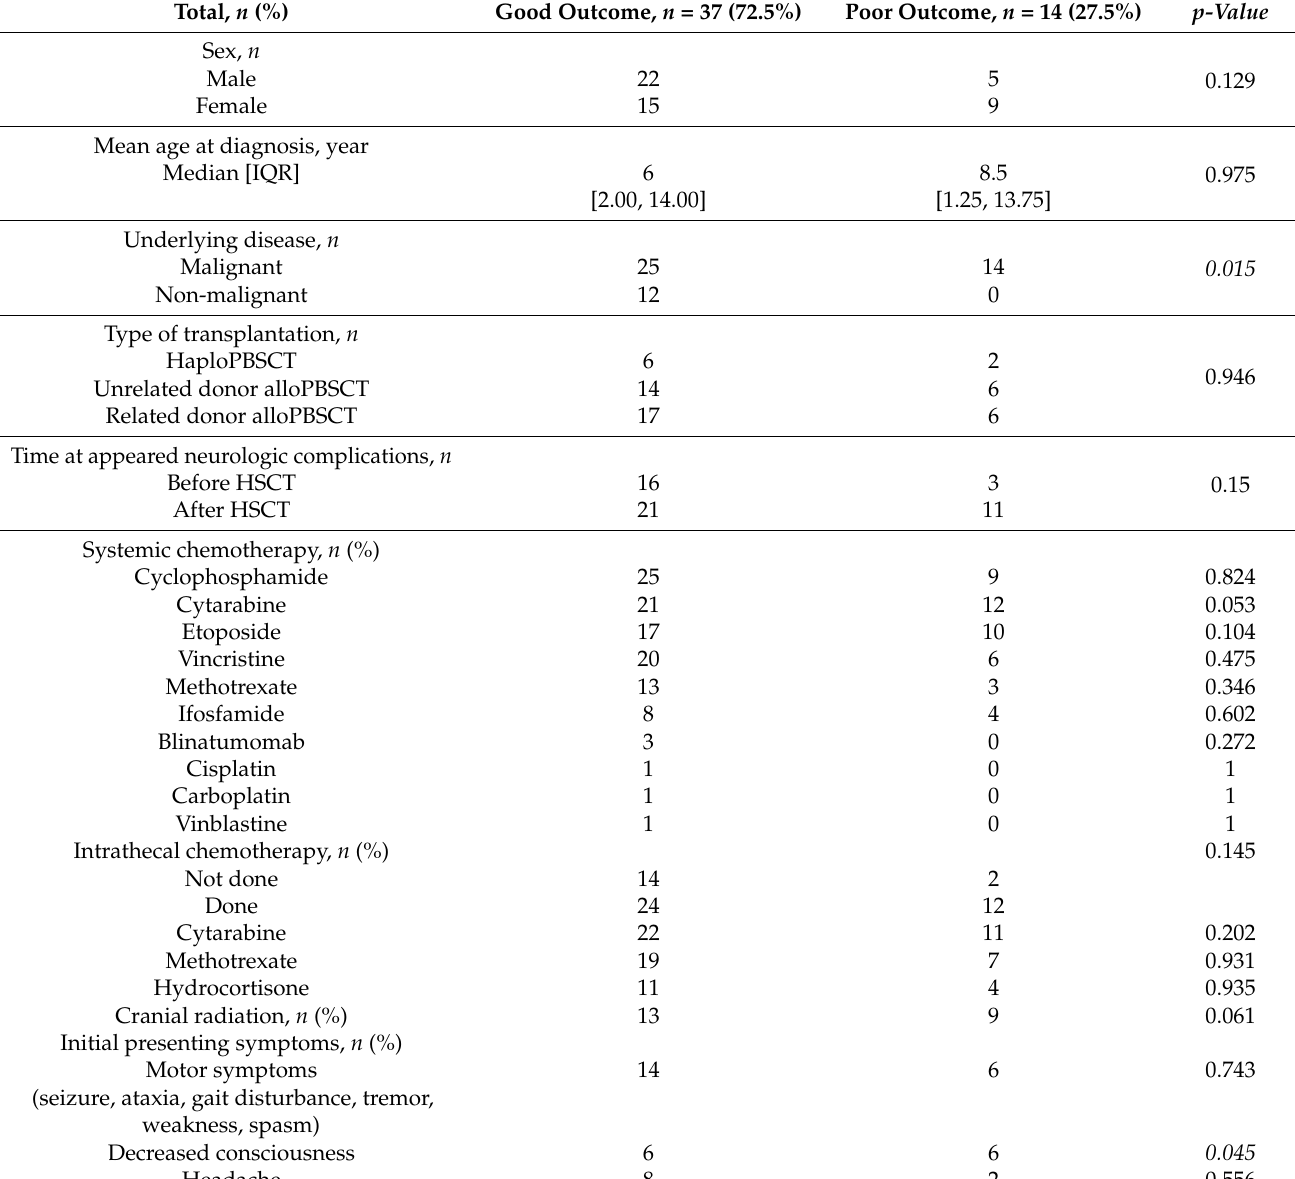
Table 3. Neurological outcome assessments in patients with MRI